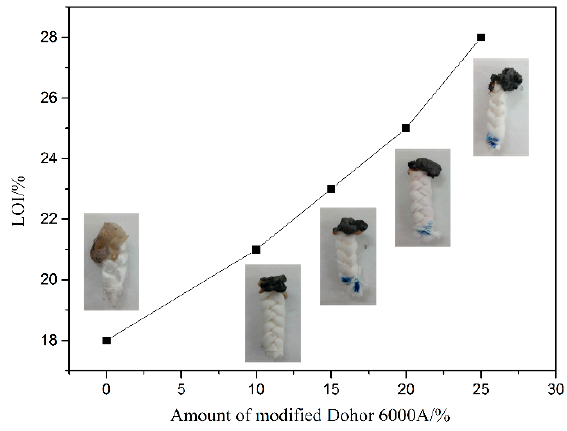
Figure 7. LOI values and the digital photos after LOI test of the fibers.